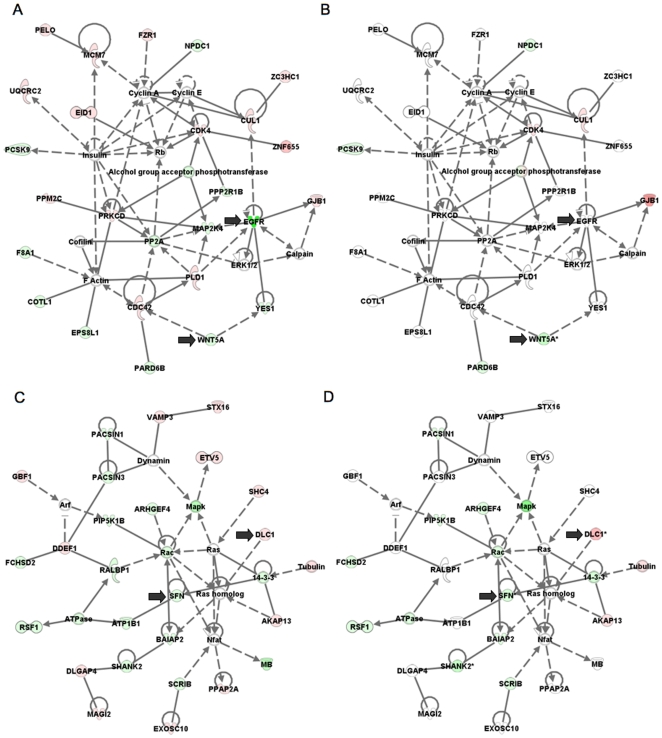
Network analysis was performed to provide a graphical representation of genes having known biological relationships.The EGFR and Mapk networks presented are shown in duplicate, with (A and C), displaying genes comprising the four insecting subregions shown in Figure 6 (regions 1,2,3 and 4) and (B and D) displaying genes comprising the two intersecting subregions (regions 1 and 3) that have a methylation/expression status that is independent of copy number. Green icons indicate downregulated genes and red indicates upregulated genes. The arrows indicate selected genes that have a variable methylation status that is dependent on copy number status.